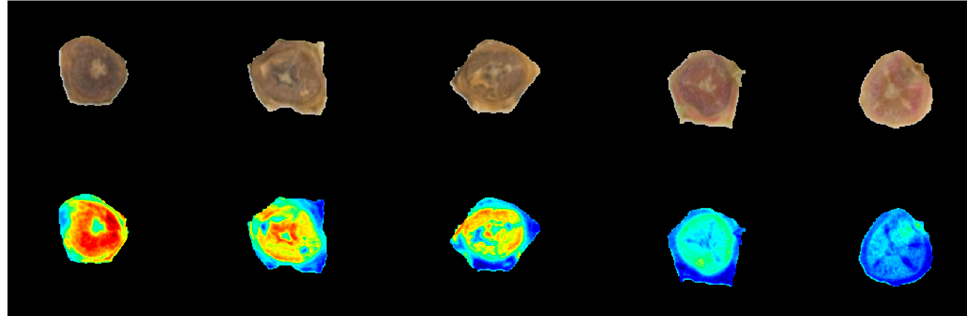
Figure 1. Seed average dry weight (mg), as a function of maturity class.